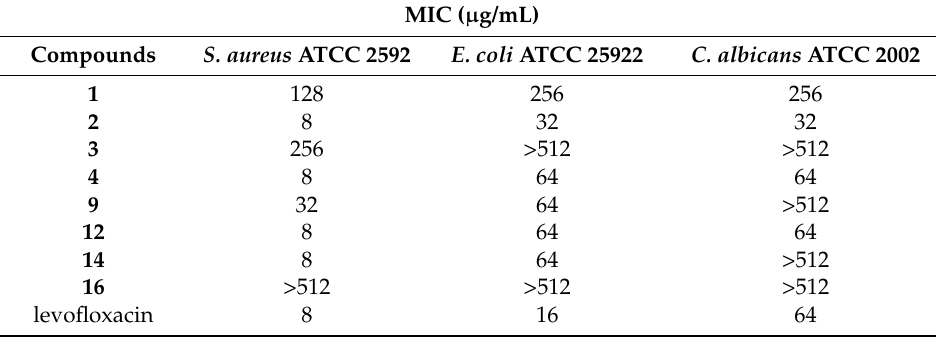
Table 3. Antimicrobial activities (MIC) of the compounds ( 1 – 4 , 9 , 12 , 14 , 16